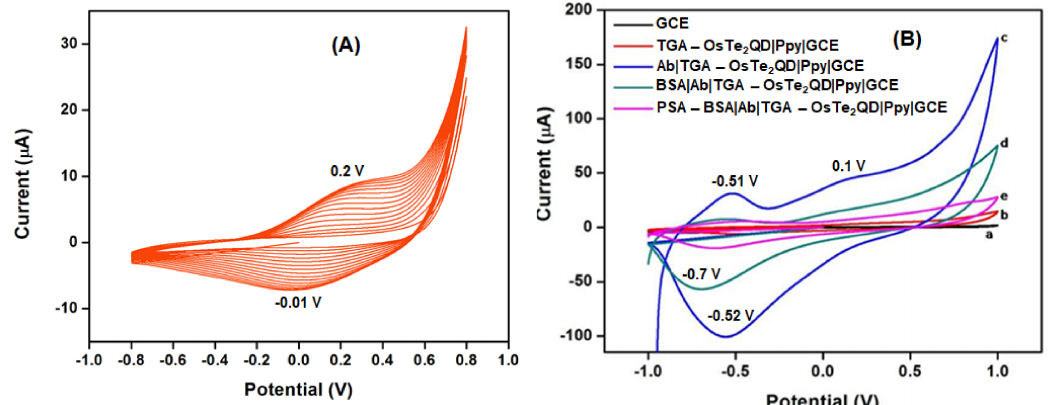
Figure 6. ( A ) Electrosynthesis of pyrrole monomer in 0.1 M LiOCl 4 solution at a potential window of − 1 to 1 V at a scan rate of 20 mV/s for 30 cycles. ( B ) CV measurements of immunosensor platform where curve a represents GCE, curve b TGA-OsTe 2 QD|PPy|GCE, curve c Ab|TGA-OsTe 2 QD|PPy, curve d BSA|Ab|TGA - OsTe 2 QD|PPy|GCE and curve e PSA|BSA|Ab|TGA-OsTe 2 QD|PPy|GCE (for 10 ng/mL PSA) in 0.1 M PBS at 20 mV/s in the potential window of − 1 to 1